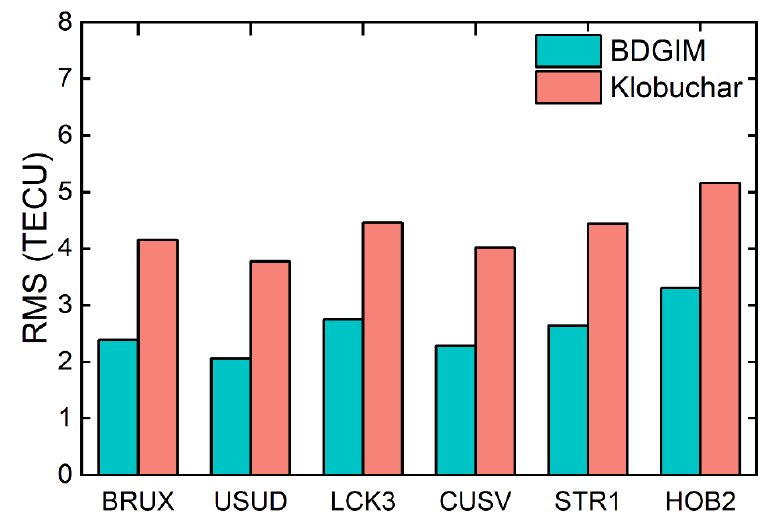
Figure 4. RMS errors of dVTEC between the broadcast ionosphere model and GIM.